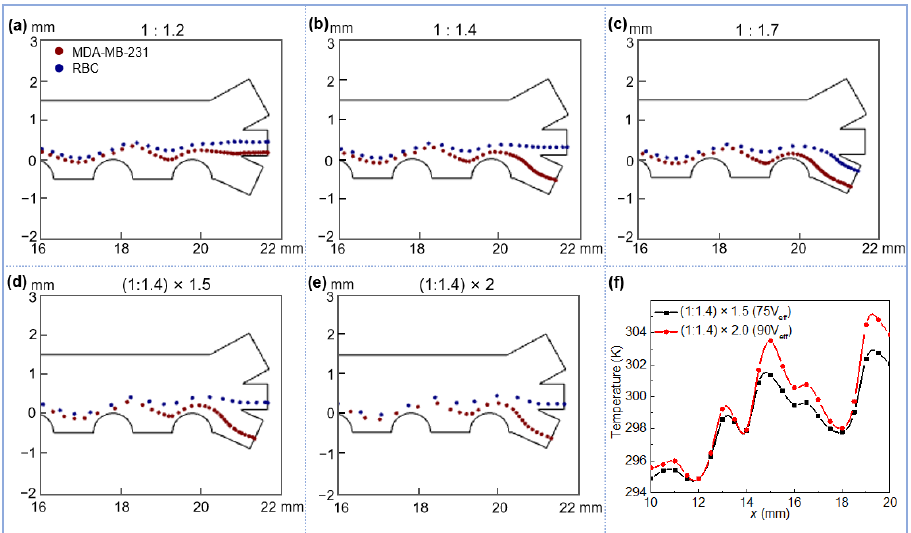
Figure 6. Separation of RBC and MDA-MB-231 at different flow ratios: ( a ) 1:1.2 ( b ) 1:1.4 ( c ) 1:1.7; the increase of both flow velocities by ( d ) 1.5 and ( e ) 2 times, respectively, while maintaining the same flow ratio of 1:1.4; ( f ) temperature profile at y = 0.1 mm (particle trajectory path) with increasing voltage and flow velocity.